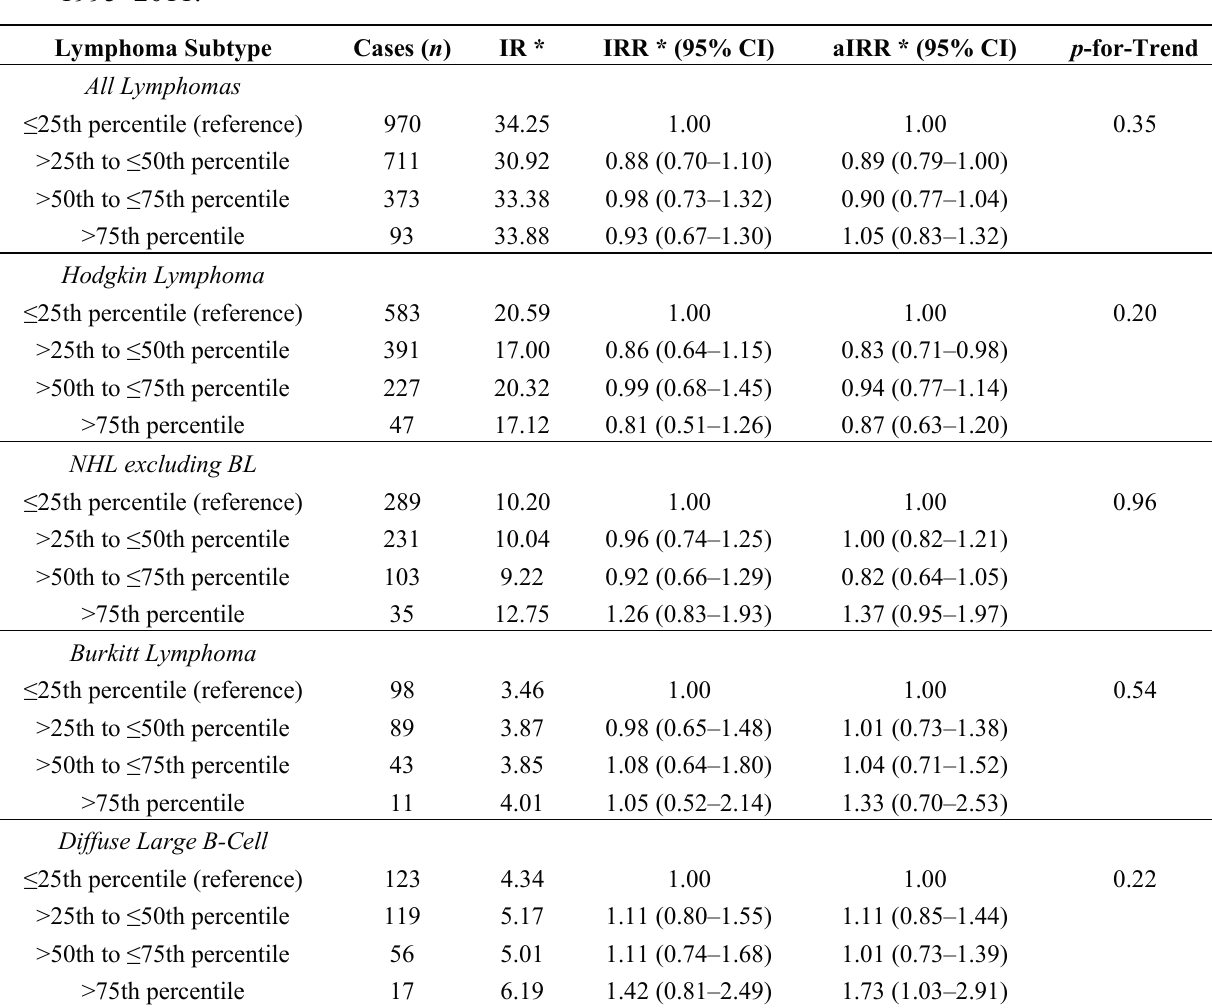
Table 4. Associations between indoor radon exposure and incidence rates of lymphoma malignancy subtypes among children and adolescents <20 years of age diagnosed in Texas,